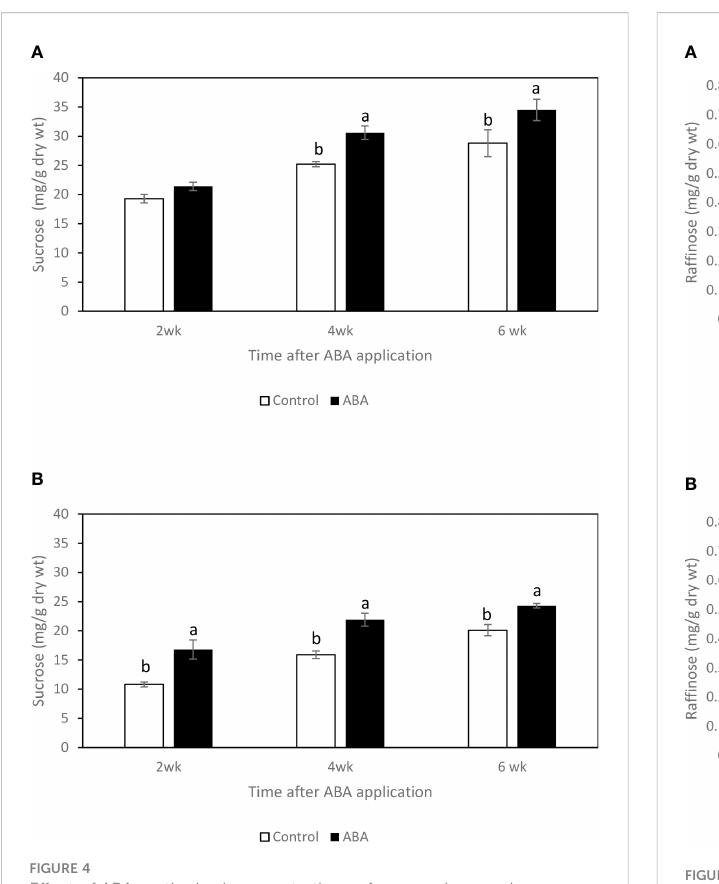
FIGURE 5 Effect of ABA on the bud concentrations of raf fi nose in greenhouse- grown grapevines (A) ‘ Chambourcin ’ and (B) ‘ Cabernet franc ’ . Bars with different letters are signi fi cantly different at p ≤ 0.05. (n = 4). Standard errors are presented.